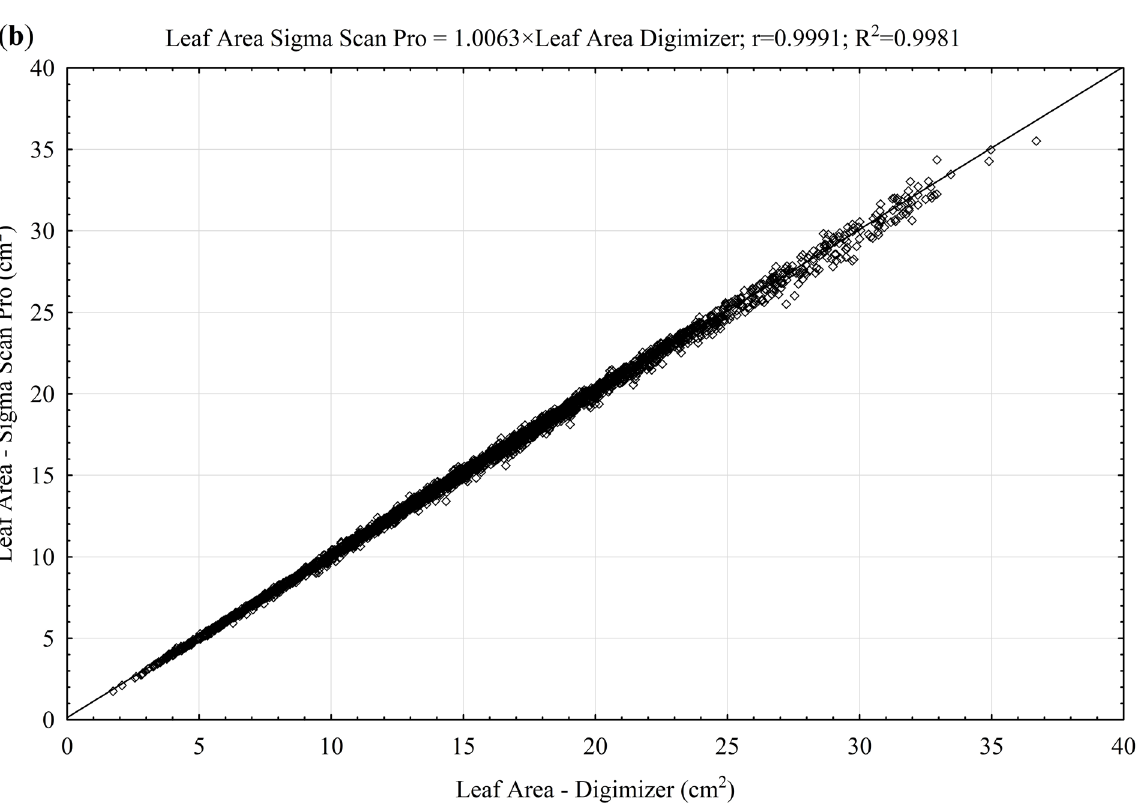
Figure 1b - Relationship of leaf area determined by Digimizer software and leaf area determined by Sigma Scan Pro software in 3,200 leaves of Crotalaria juncea